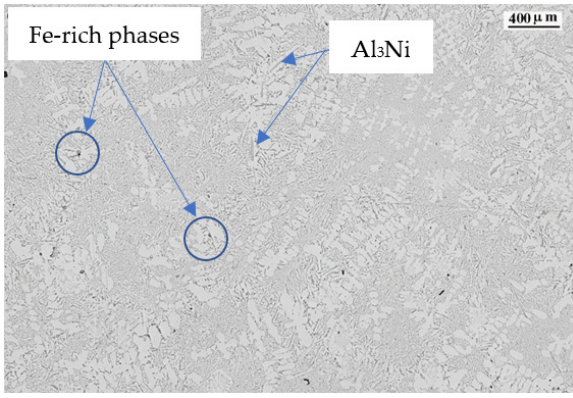
Figure 7. Microstructure of alloy 16.